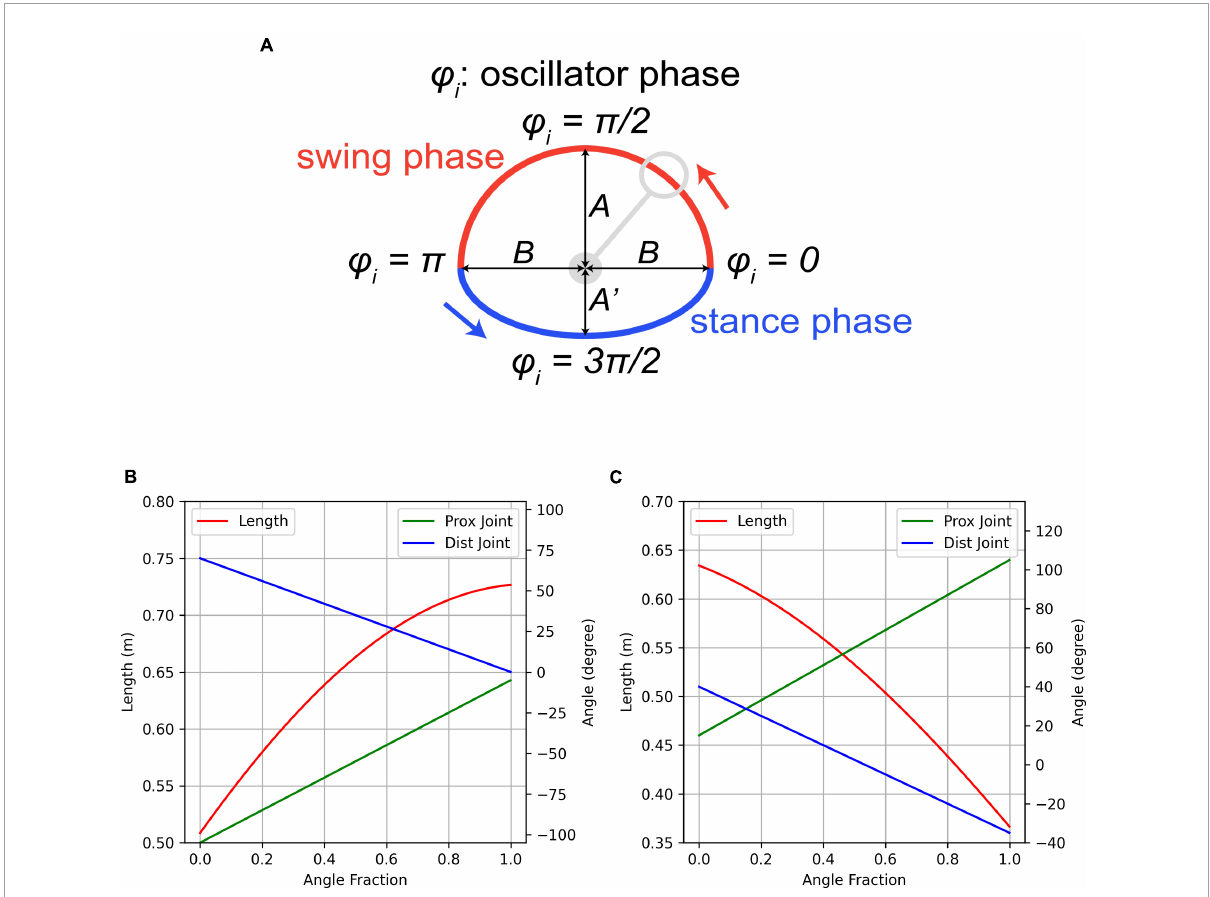
FIGURE1 Diagram illustrating the control process. (A) Phase diagram for the tegotae controller illustrating the movement of the target point. (B) Forelimb joint angle controller illustrating how the angle fraction specifies the individual joint angles and the overall length. (C) Hindlimb joint angle controller illustrating how the angle fraction specifies the individual joint angles and the overall